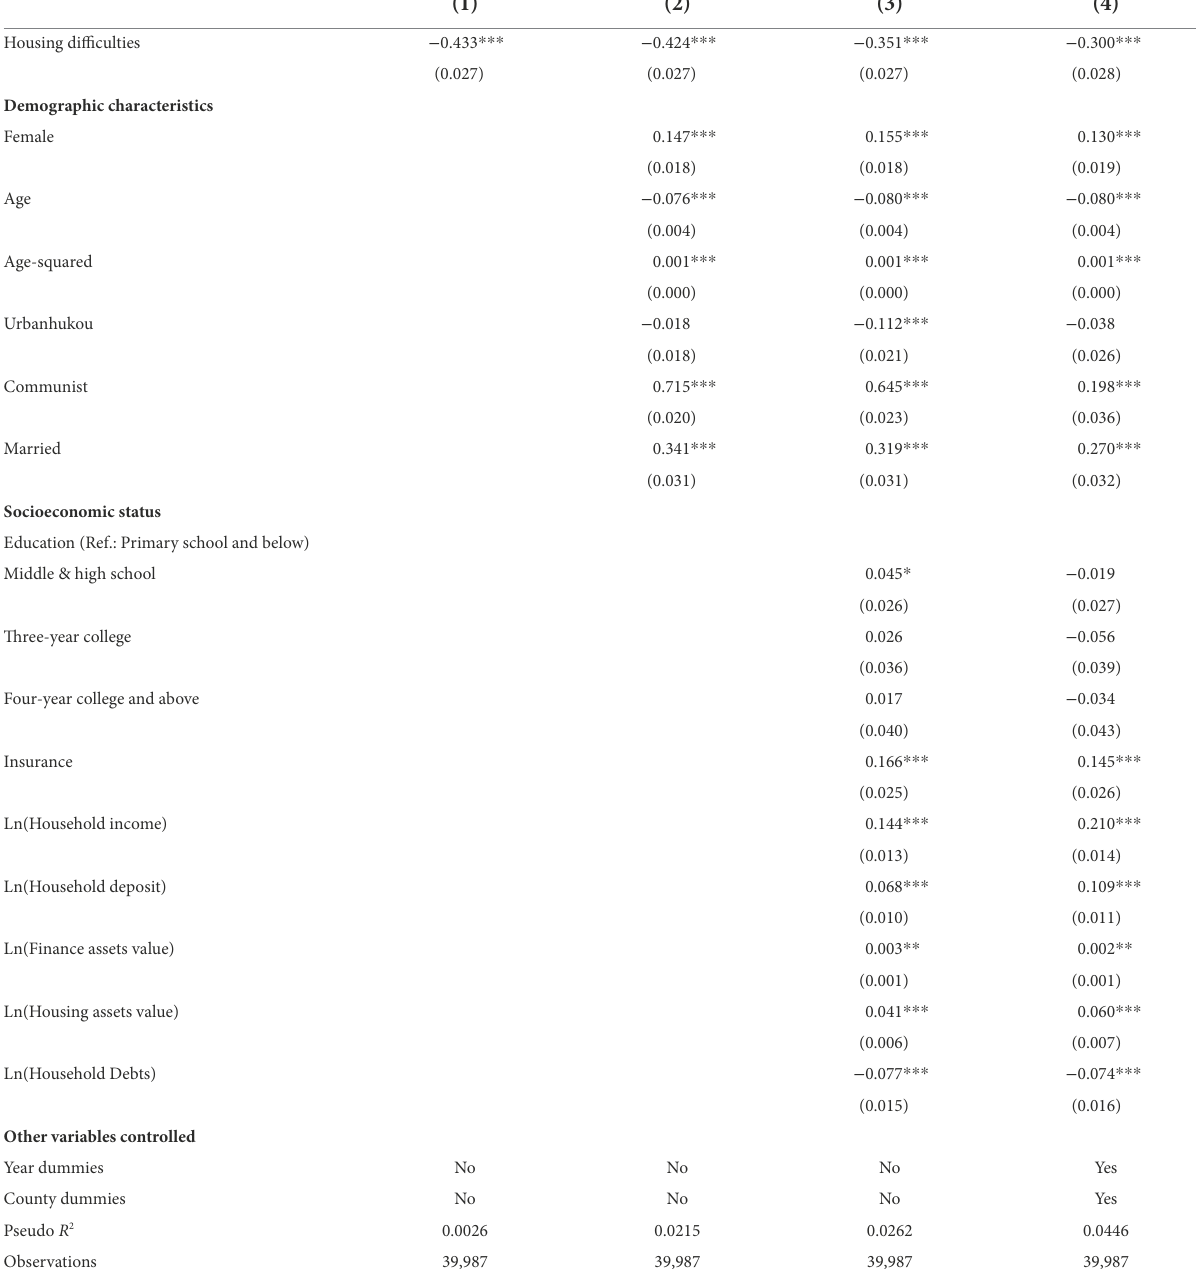
TABLE 2 Impact of housing difficulties on life satisfaction (ordered logit